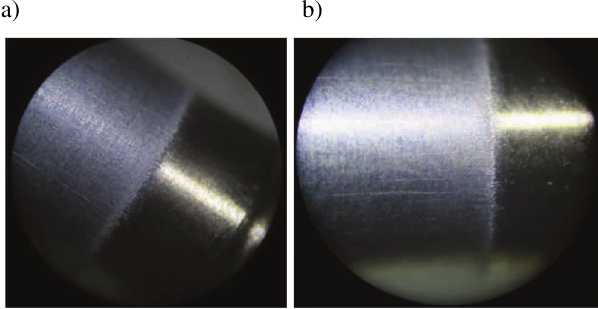
Fig. 19. Corrosion of the needle and the guiding sleeve